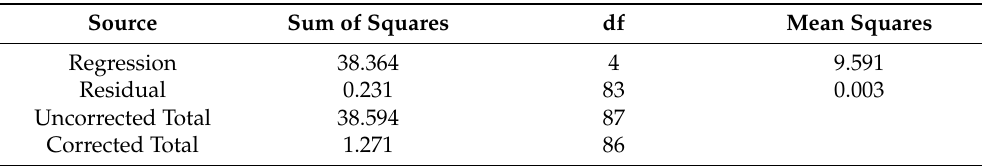
Table 5. ANOVA of the PIPR Regression.